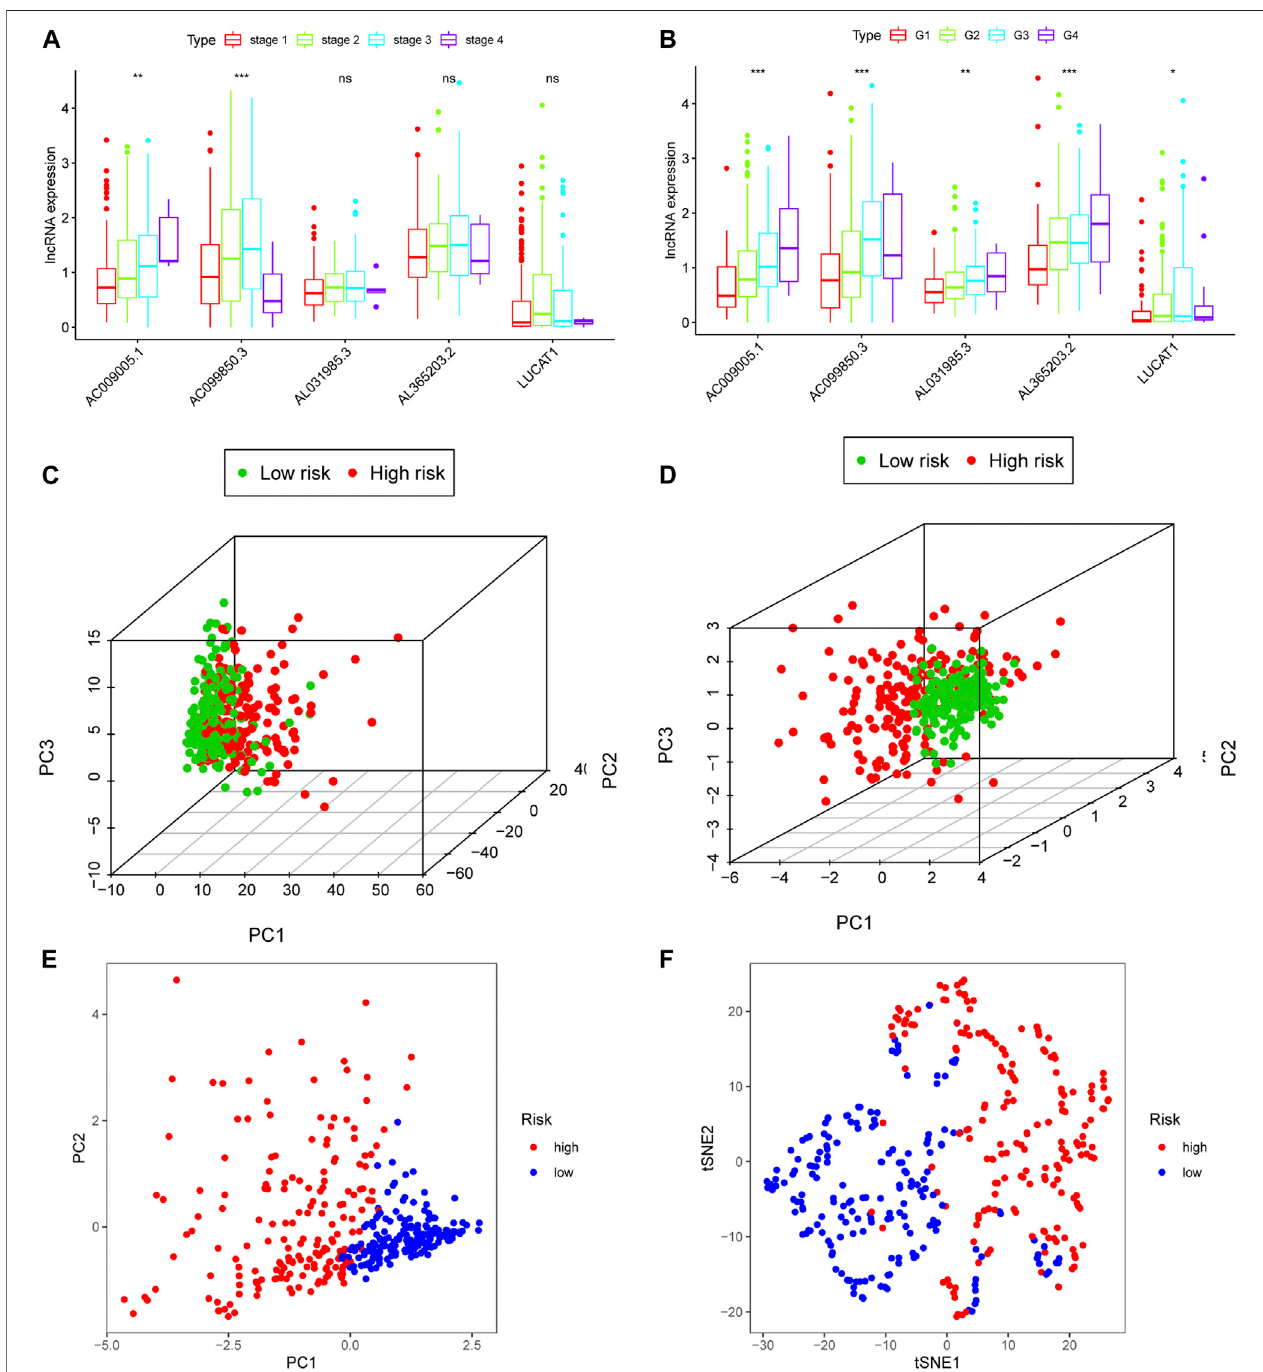
FIGURE4| Clinicalprognosticanalysisofthe fi veferroptosis-relatedlncRNAmodels. (A) Relativeexpressionof fi veferroptosis-relatedlncRNAsinHCCpatientsat different clinical stages. (B) Relative expression of fi ve lncRNAs in various cancer grades. (C) 3D-PCA plot ofHCC patients divided into high- and low-risk groups based on gene expression (all genes). (D) 3D-PCA plot ofHCC patients divided into high- and low-risk groups based on the expression of the fi ve ferroptosis-related lncRNAs. (E) 2D-PCA plot of patients based on the expression of the fi ve ferroptosis-related lncRNAs. (F) t-SNE plot of patients. lncRNA: long non-coding RNA; 3D/2D: three/two dimensional; PCA: principal component analysis.